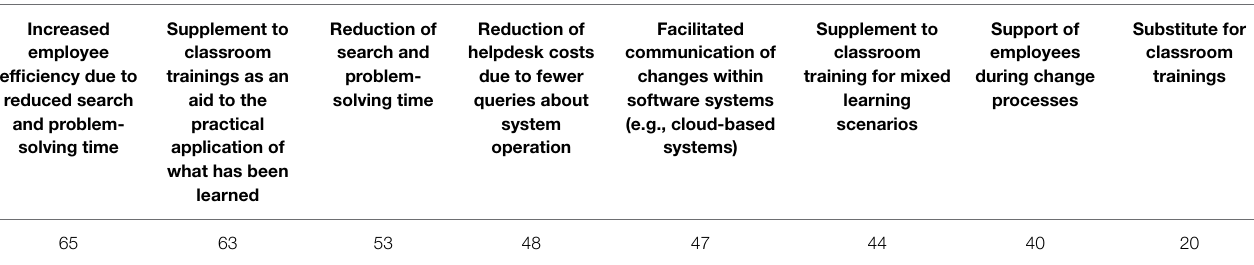
TABLE 3 | Perceived advantages of